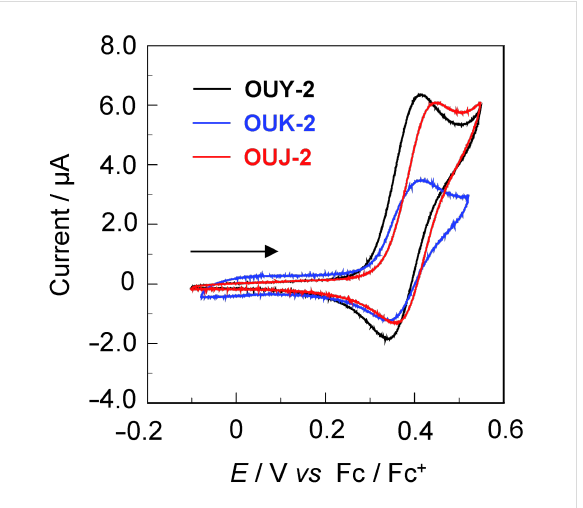
Figure 5: Cyclic voltammograms of OUY-2 , OUK-2 and OUJ-2 in DMF containing 0.1 M Bu 4 NClO 4 . The arrow denotes the direction of the potential